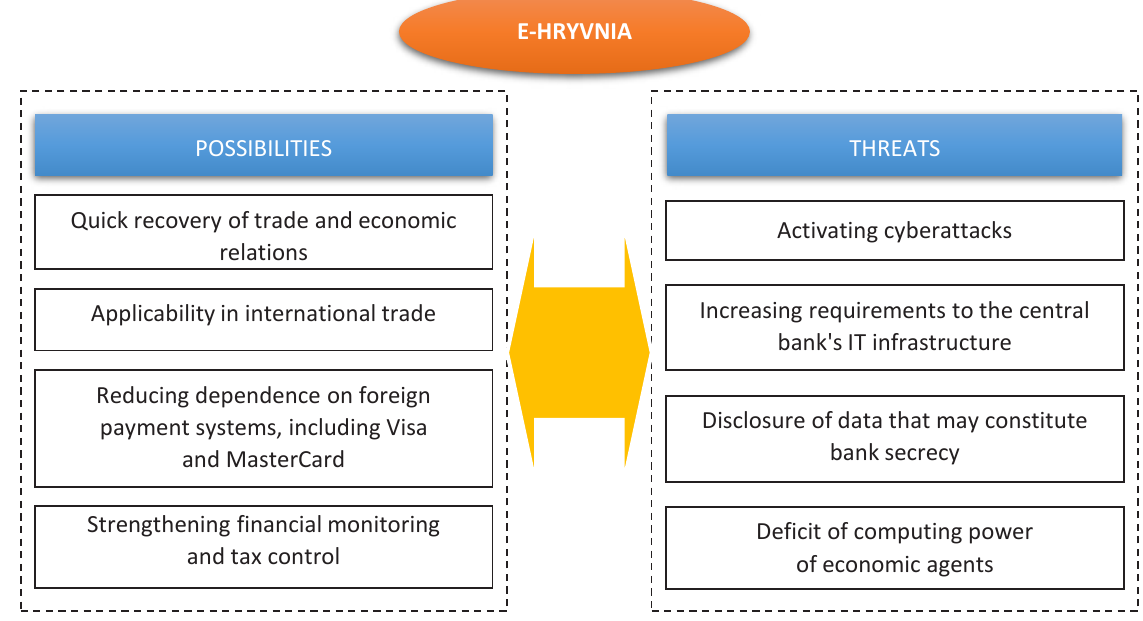
Figure 4. Position of e-hryvnia in the post-conflict economic reconstruction